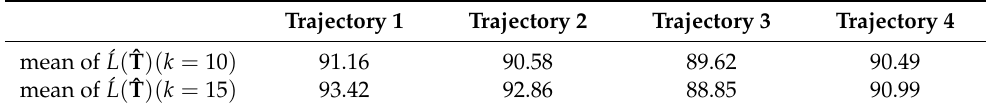
Table 2. Mean values of ´ L ( ˆT ) for four trajectories at two observation